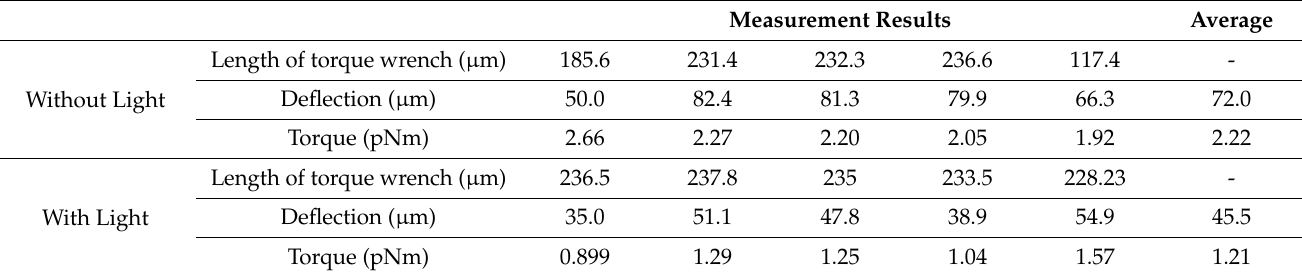
Table 1. Experimental results.